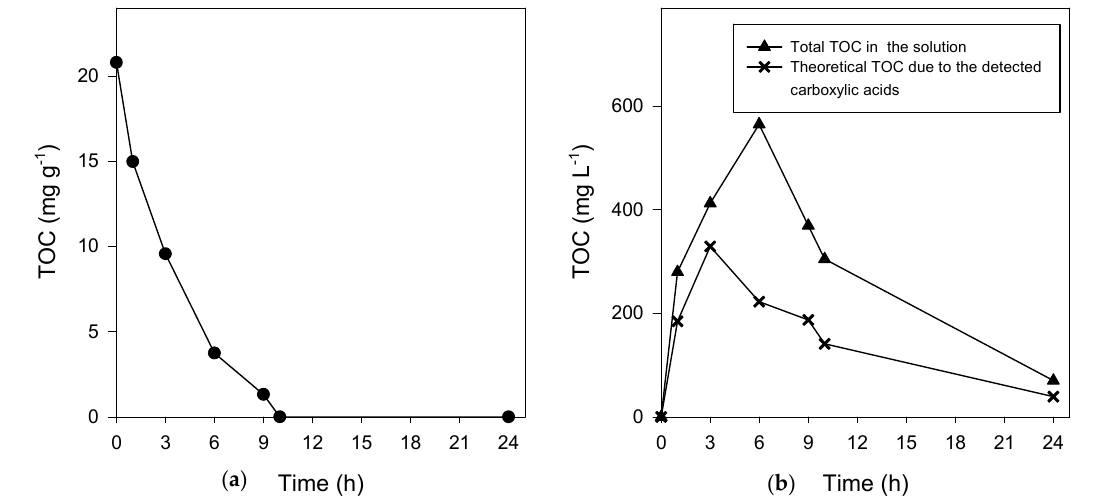
Figure 3. TOC measurement in ( a ) the adsorbent and in ( b ) the solution during treatment under optimal